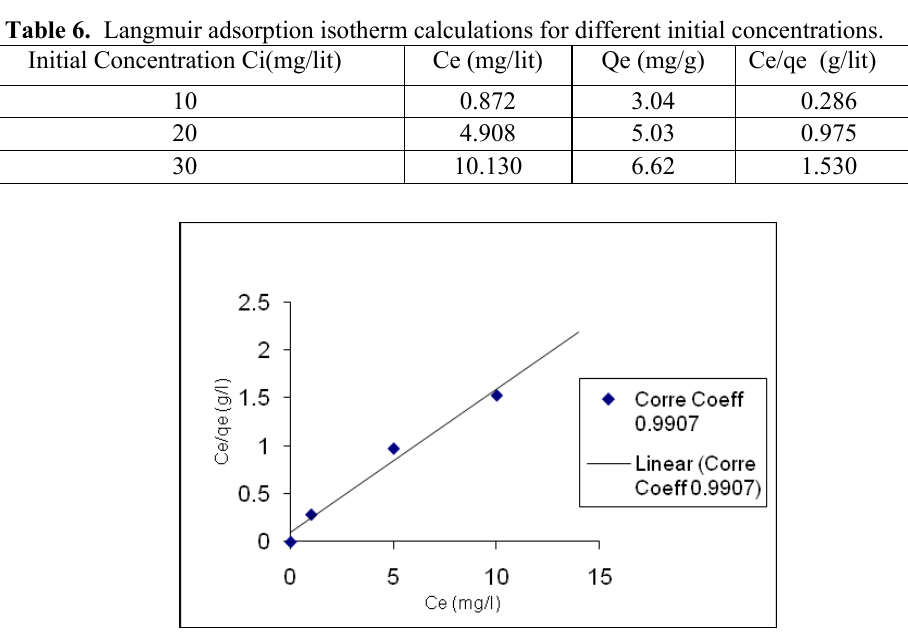
Figure 5. Langmuir adsorption isotherm for equilibrium concentrations and initial